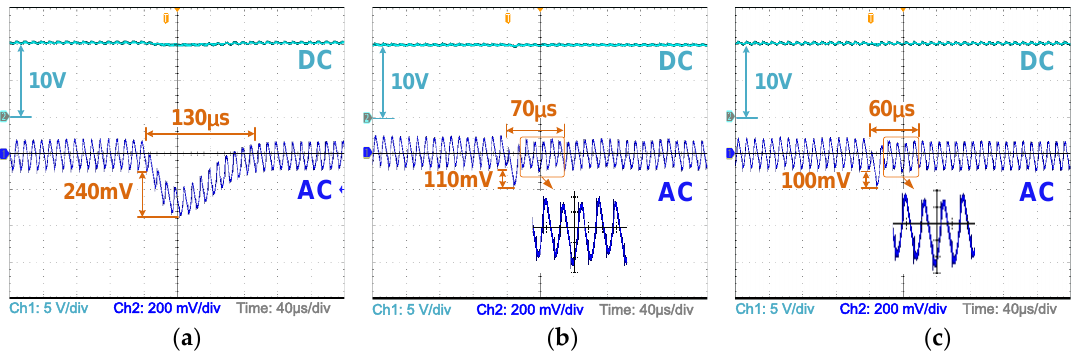
Figure 15. Output voltage transient responses when the input voltage steps from 20 V to 18 V ( a ) PI control ( b ) discrete charge balance (DCB) control ( c ) linearized discrete charge balance (LDCB) control.